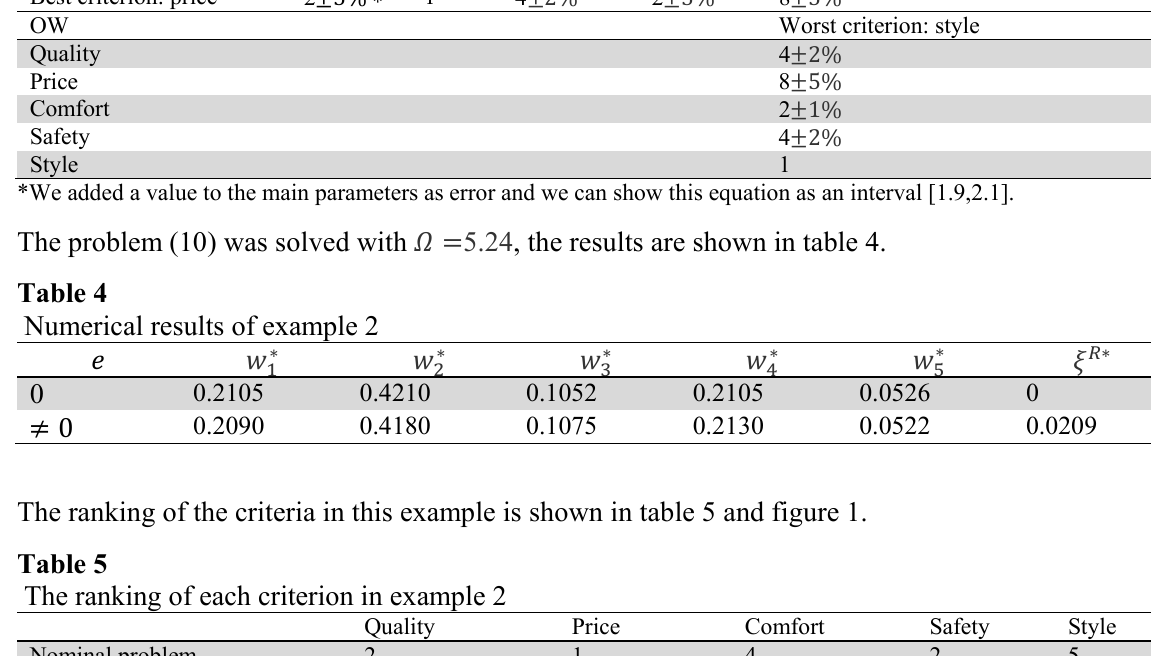
Best-to-others (BO) and others-to-worst (OW) pairwise comparison vectors for Example 2 BO Quality Price Comfort Safety